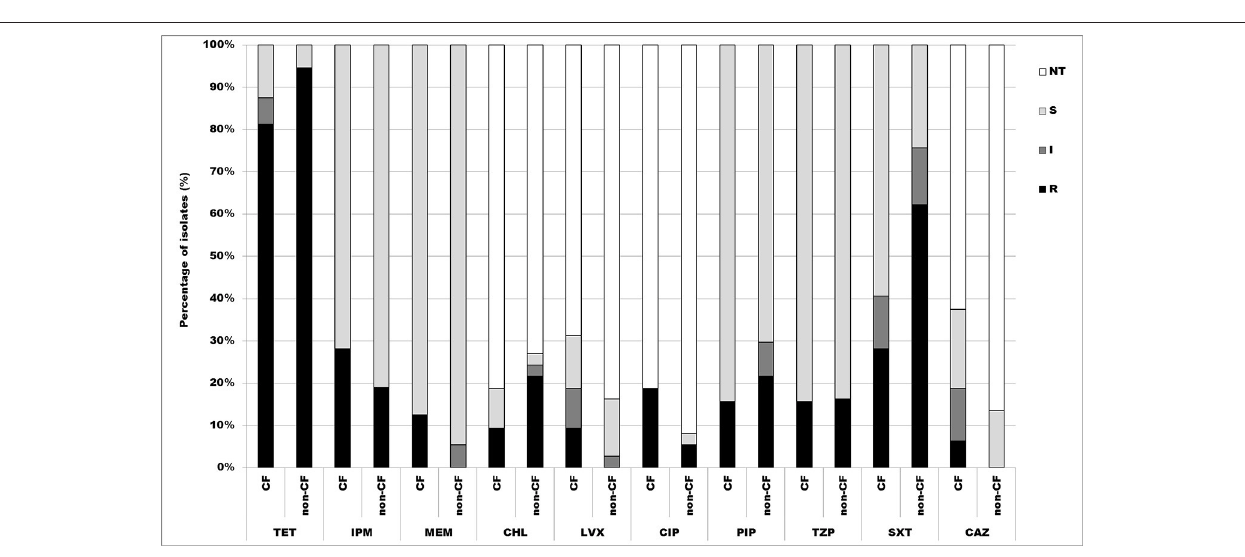
FIGURE 4 | Distribution of antibiotic resistances among CF and non-CF Achromobacter spp. isolates determined by microdilution method. TET, tetracycline; IPM, imipenem; MEM, meropenem; CHL, chloramphenicol; LVX, levofloxacin; CIP, ciprofloxacin; PIP, piperacillin; TZP, piperacillin/tazobactam; SXT, trimethoprim/sulfamethoxazole; CAZ, ceftazidime; NT, not tested; S, sensitive; I, intermediate; R, resistant.